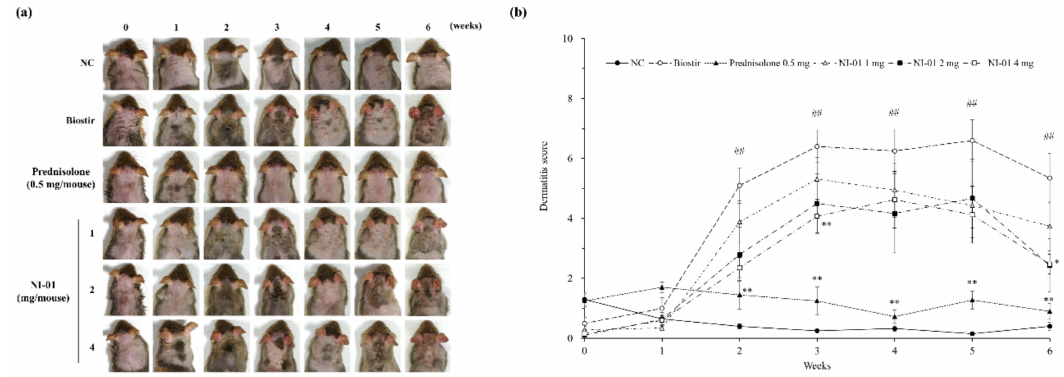
Figure 4. E ff ect of NI-01 on the severity of atopic dermatitis in house dust mite treated NC / Nga mice. Features of lesions ( a ) and dermatitis score ( b ) were assessed once a week for 6 weeks. Dermatitis scores were calculated as sums of individual scores, graded as 0 (none), 1 (mild), 2 (moderate), and 3 (severe) for the five signs: pruritus / itching, erythema / hemorrhage, edema, excoriation / erosion, and scaling / dryness. Prednisolone was used as a positive control. The data are expressed as the mean ± SEM ( n = 8). ## P < 0.01 compared with the normal control group; * P < 0.05 and ** P < 0.01 compared with the Biostir-AD ® group. NC; normal control, Biostir; Biostir-AD ® group.